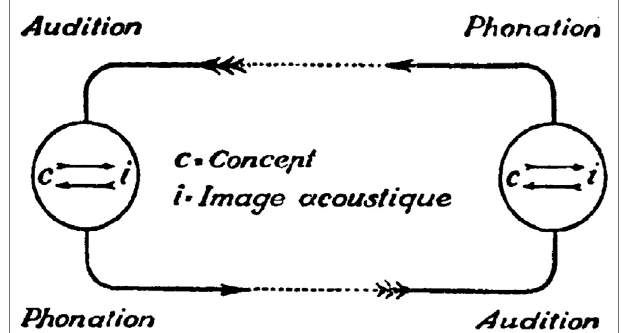
FIGURE 2 | Phases of saussurean Circuit (Saussure 1967: CLG 60).